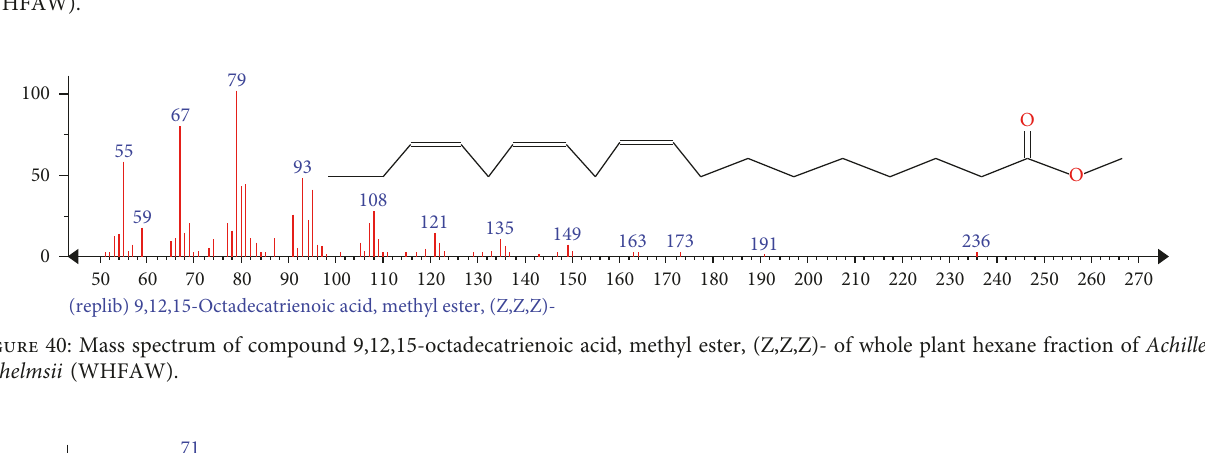
Figure 39: Mass spectrum of compound 9,12-octadecadienoic acid, methyl ester, (E,E)- of whole plant hexane fraction of Achillea wilhelmsii